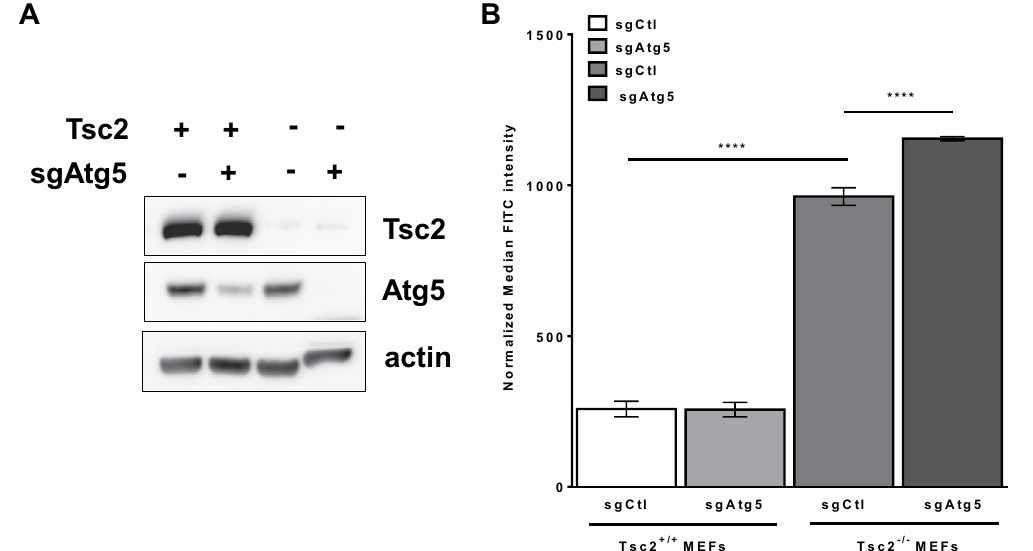
Figure 2. Macropinocytosis is further increased by autophagy inhibition in Tsc2-deficient cells. ( A ) Immunoblots confirmed Atg5 knockout in Tsc2 + / + and Tsc2 − / − MEFs. The blot was cropped to highlight the relevant bands. The full-length blot is presented in Supplementary Fig. 3. ( B ) Macropinocytosis was increased in Tsc2 − / − sgAtg5 MEFs compared to Tsc2 − / − sgCtl MEFs. Median fluorescent intensity of FITC-Dextran was quantified by flow cytometry. Data represented as mean + / − standard deviation of three biological replicates. Statistical significance was assessed using two-way and one-way ANOVAs with Bonferroni correction with **** p <